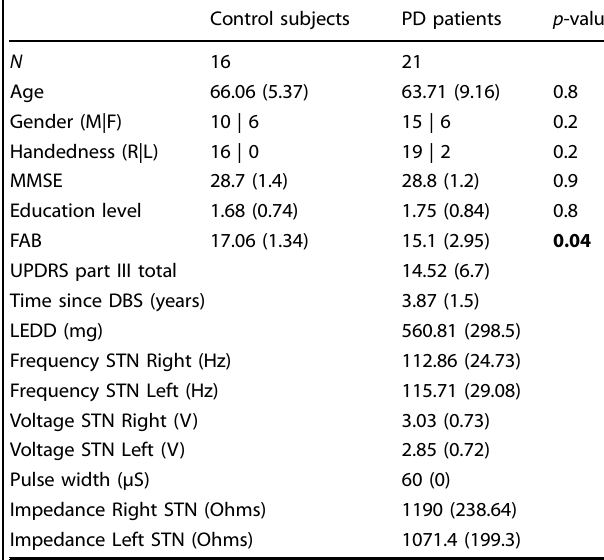
Table 2. Demographic and clinical data of patients and